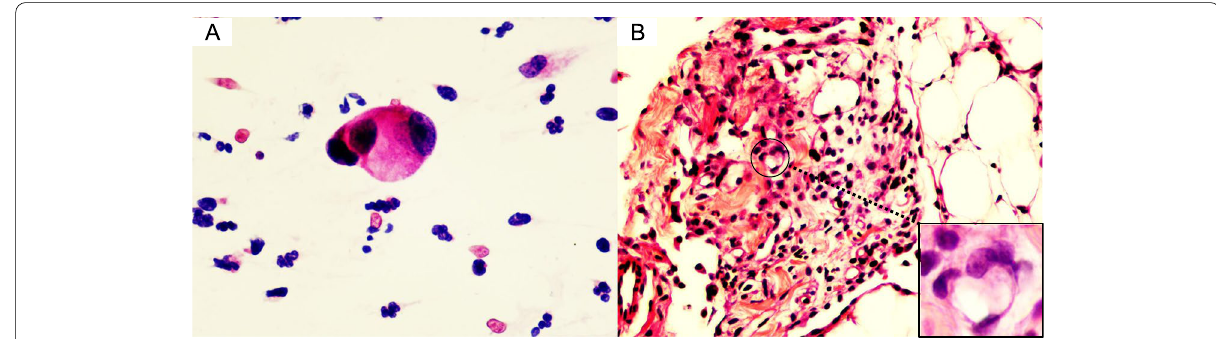
Fig. 2 The false‑positive case in peritoneal effusion specimens. The cytological diagnosis was ‘SFM (IVa)’ ( A , HE, result was chronic inflammation ( B , HE, 200). We think that the fibroblasts (bottom right of Figure B) may have been mistaken for ×